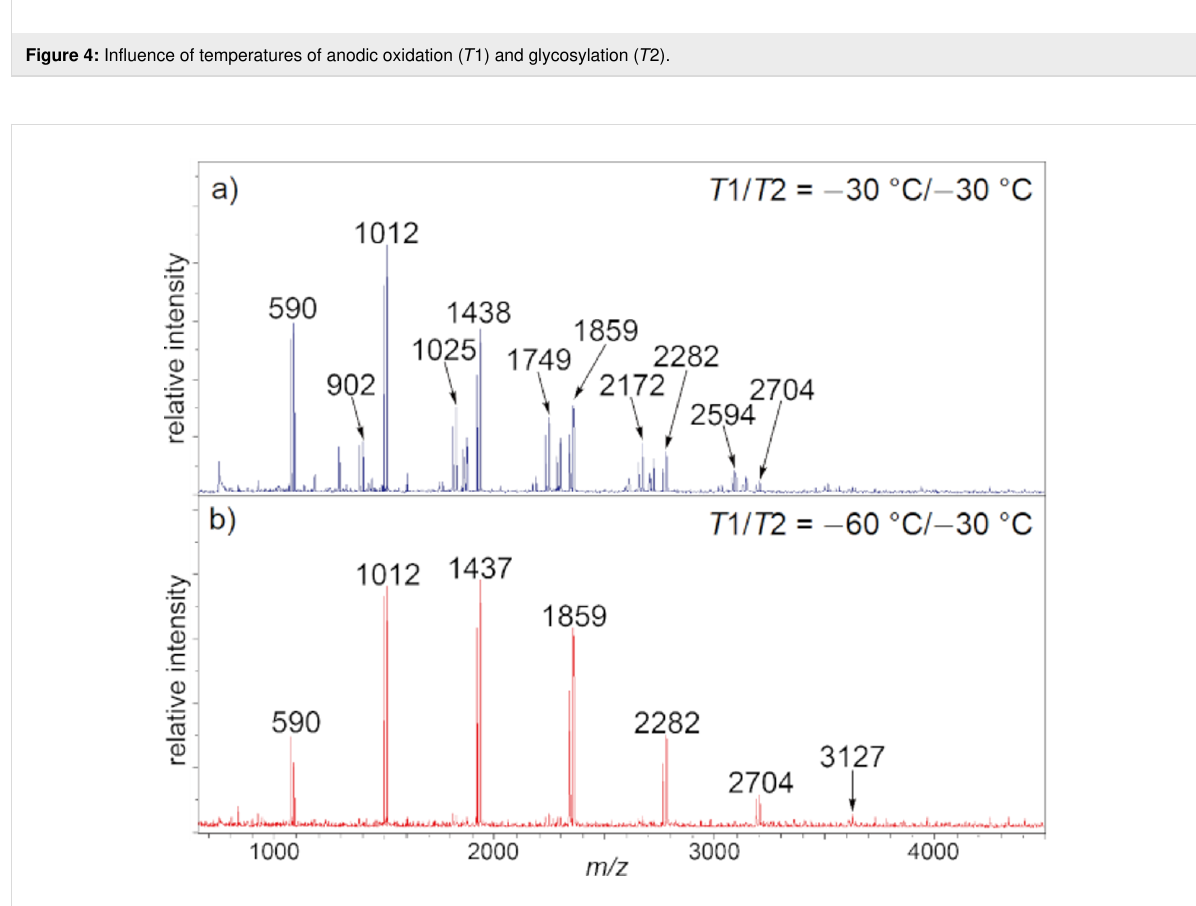
Figure 5: MALDI–TOF MS spectra of